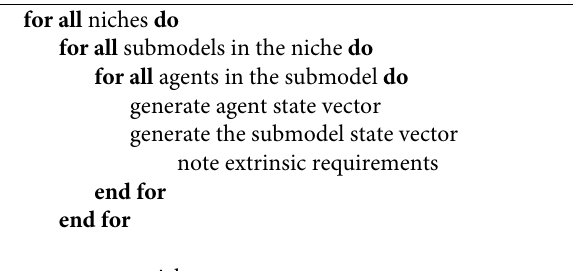
Algorithm 1 | Basic processing pass for the